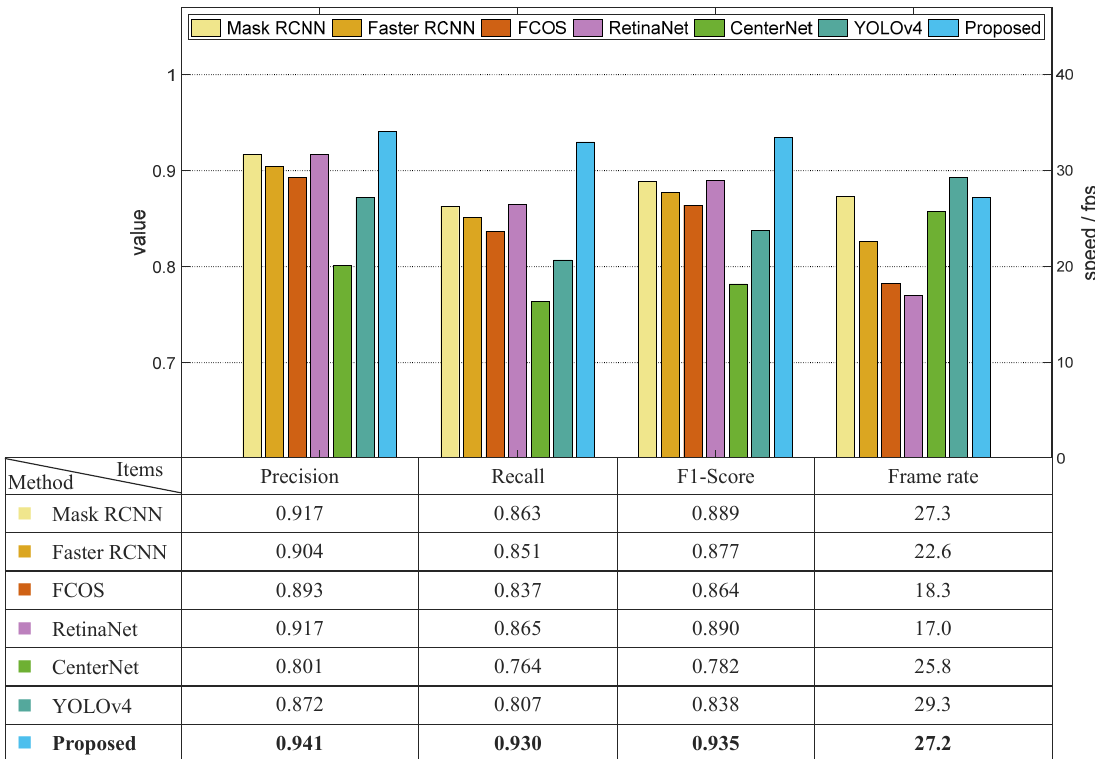
Figure 9. Results of the comparison experiment using dataset S.